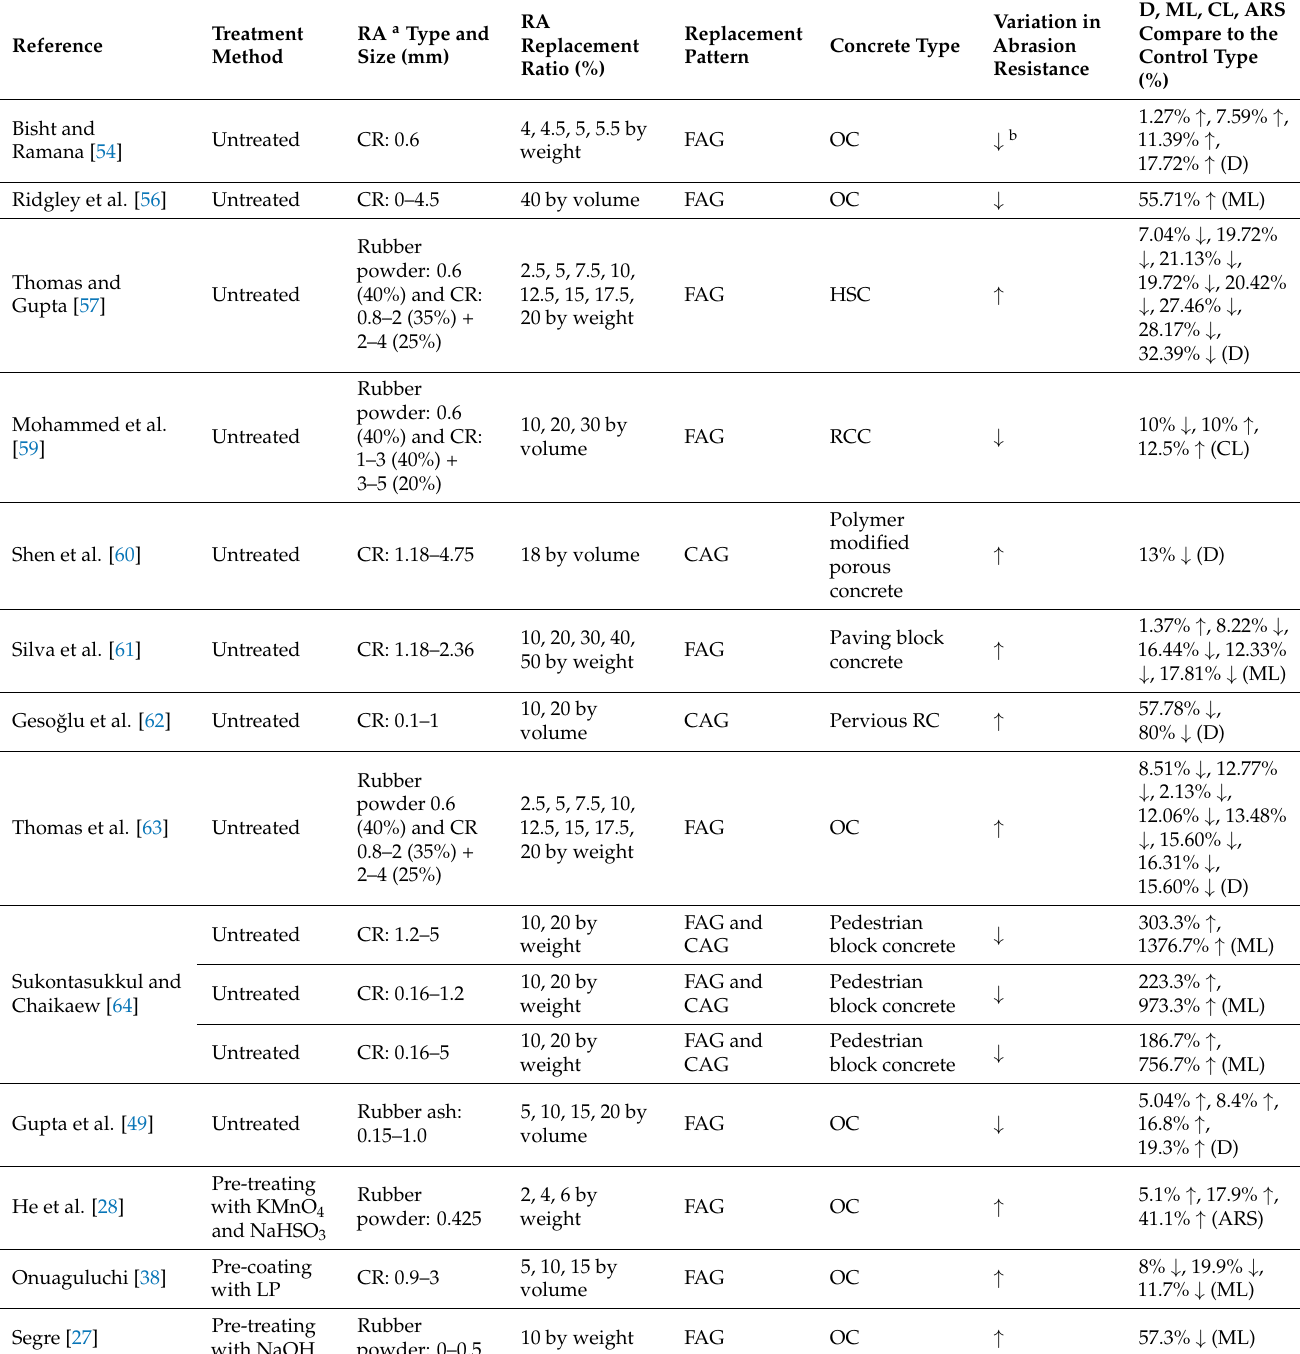
Table 5. Influence of rubber on the concrete abrasion